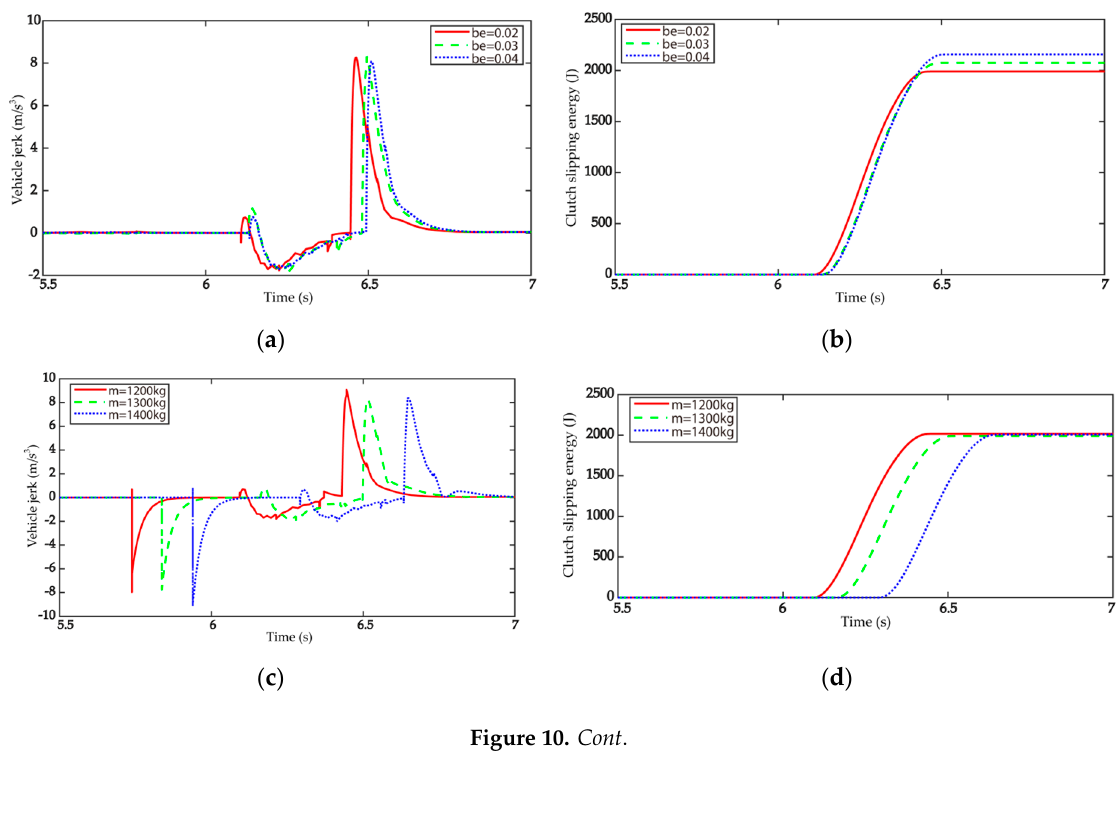
Figure 9. Comparison result in simulation. ( a ) Engine and EM torque, ( b ) engine and EM speed, ( c ) vehicle jerk , ( d ) clutch slipping energy